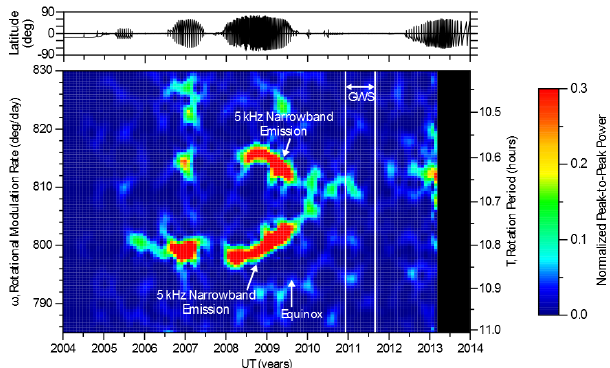
Figure 2. Normalized peak-to-peak power of Saturn narrowband radio emission modulation. The display is similar to Fig. 1, and the upper panel shows the planetocentric latitude of Cassini as a func- tion of time. Narrowband emissions at 5kHz are more frequently observed from high latitudes, leading to strong modulation signals during Cassini’s high-latitude orbits. The modulation rate shows a kink at the end of 2010 when the Great White Spot (GWS) event starts and a decreasing rate afterwards. Similar to SKR in Fig. 1, there are two components until 2010, but there is only one after- wards until early